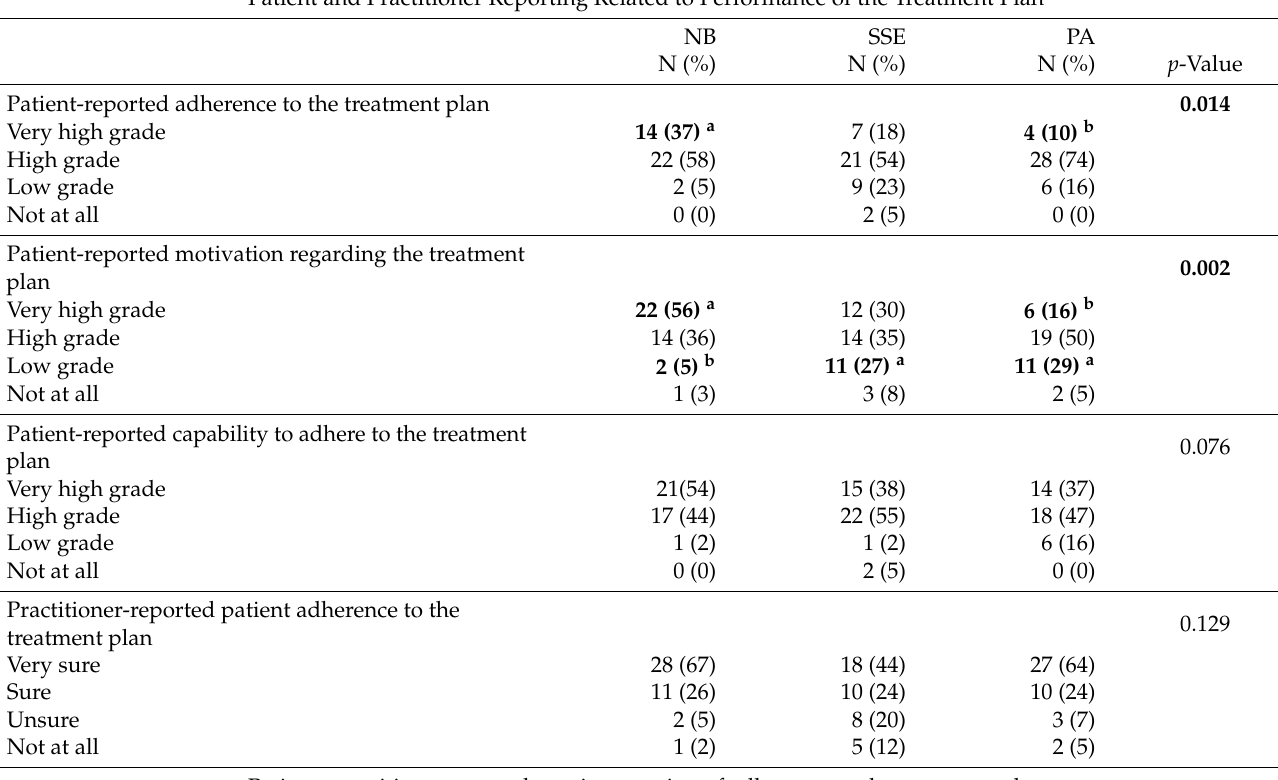
Table 2. Adherence, motivation, and capability regarding the treatment